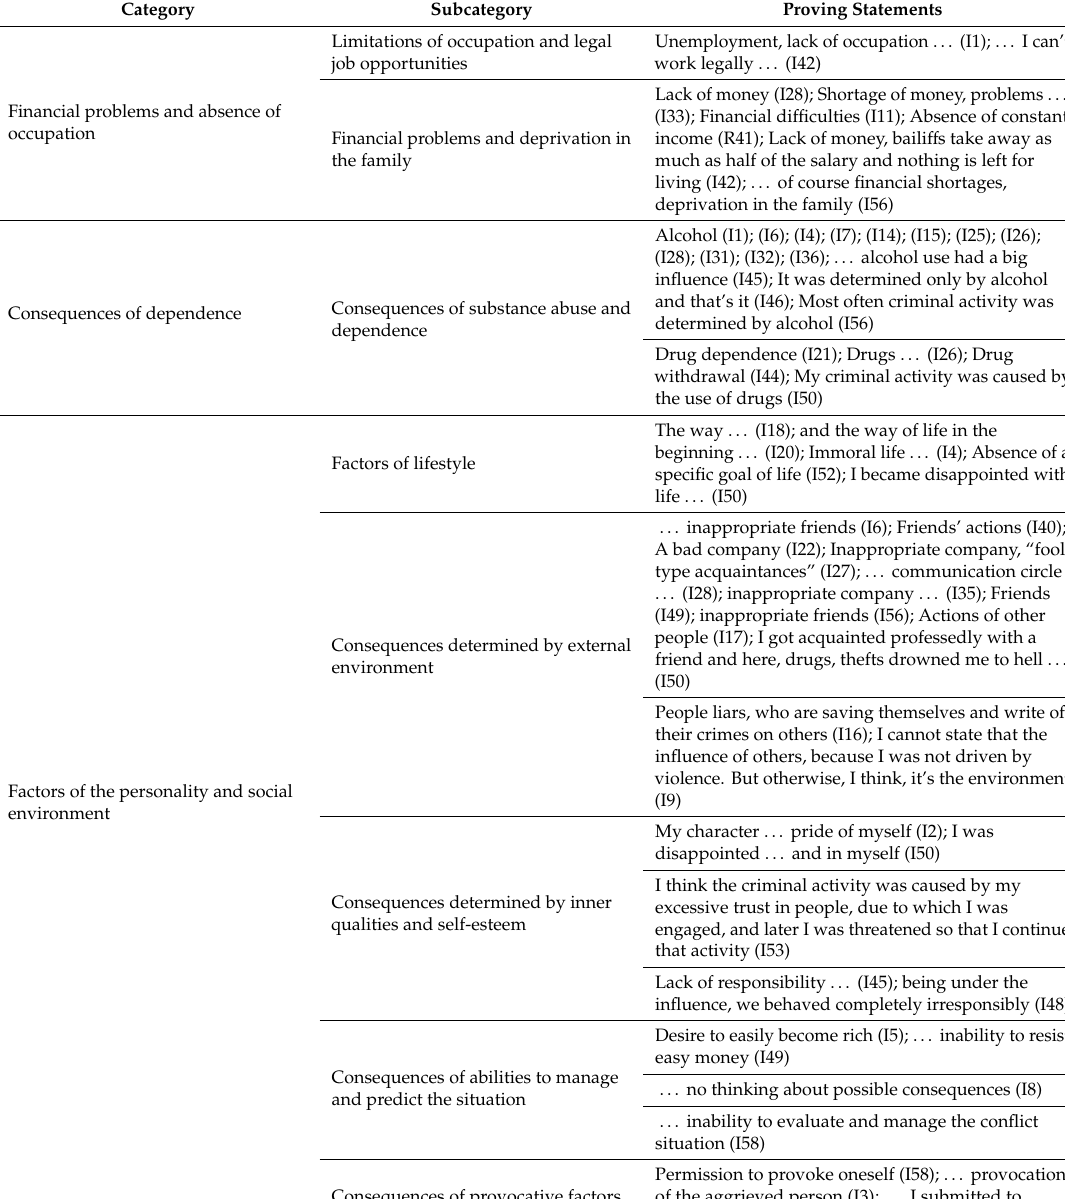
Table 1. Identification of factors that have determined criminal activity and